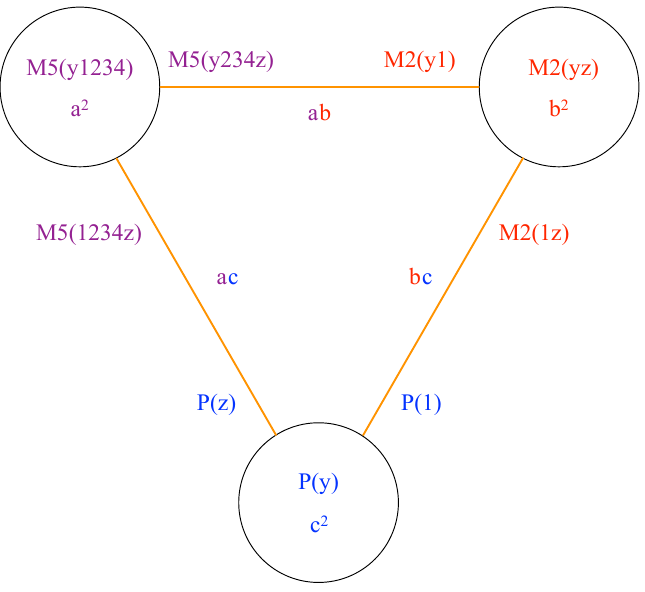
Figure 5 . The M-theory uplift of the NS5-F1-P bound state. The nodes represent the three charges of the bound state. Every combination of two nodes and the orange line joining them corresponds to a two-charge bound state, and the dipole charges and their coefficients in the projector are indicated next to the